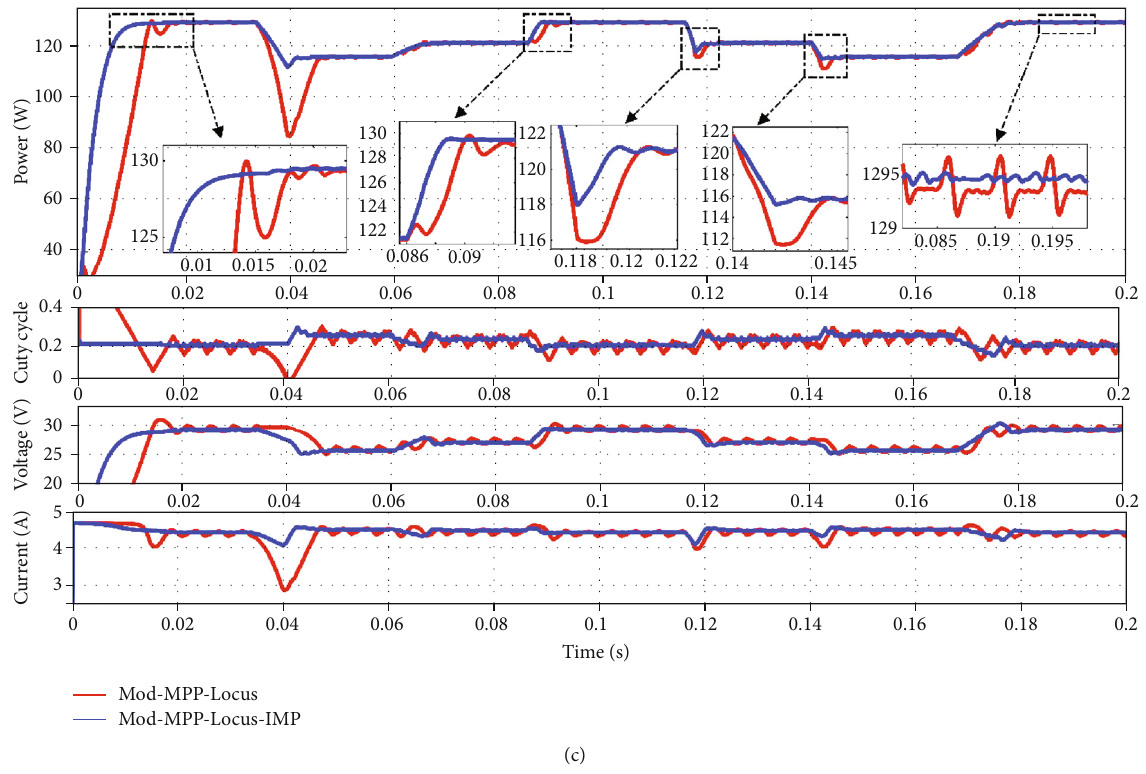
Figure 25: Simulation results from the comparison between the modi fi ed and the improved modi fi ed MPP-Locus-IMP MPPT methods under the scenario of temperature variation with constant solar irradiance: (a) 1000 W/m 2 ; (b) 800 W/m 2 ; (c) 600 W/m 2 .